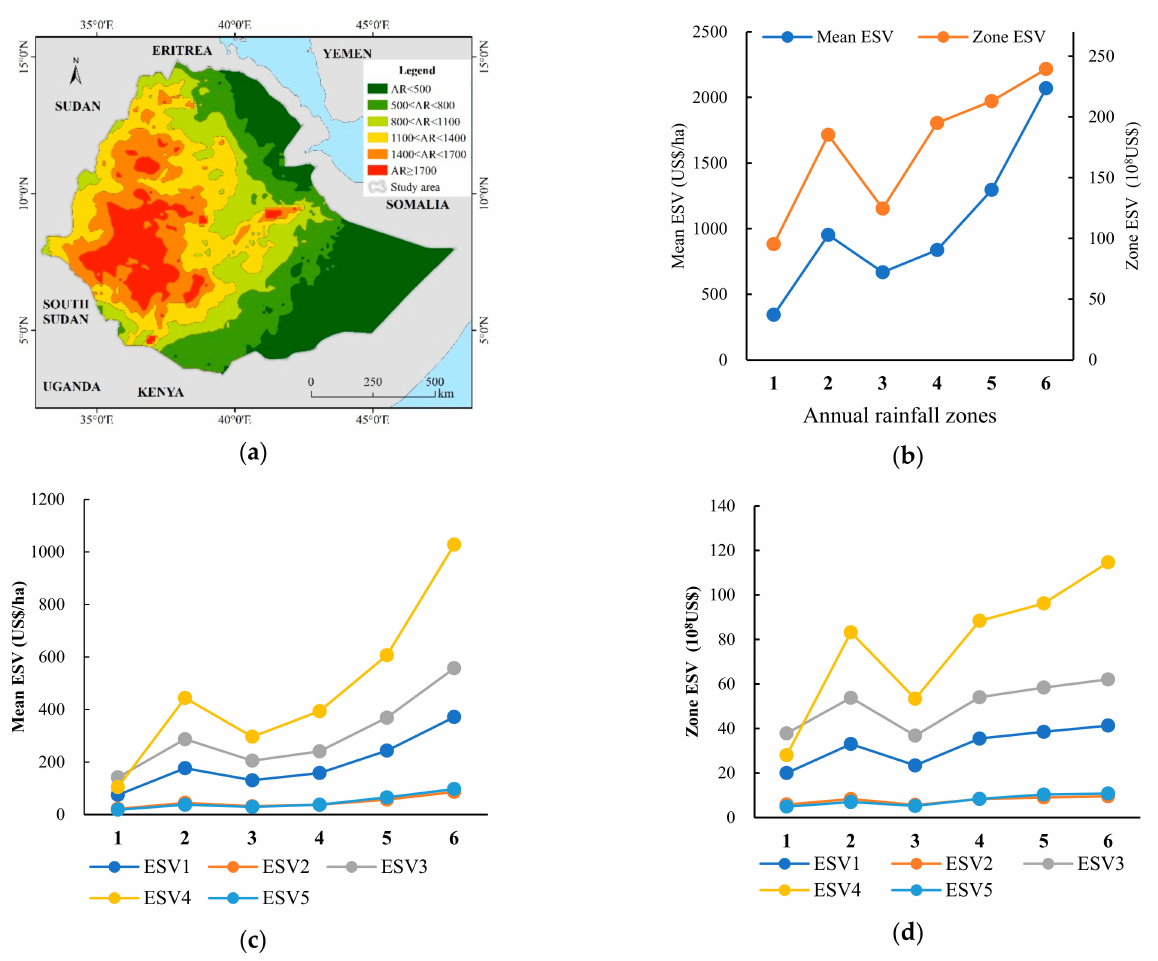
Figure 8. The annual rainfall zones and their ESV of grassland ecosystem. ( a ) the divided zones according to the annual rainfall. AR: annual rainfall. ( b ) the variation of ESV in different AR zones. ( c ) the variation of five mean ESVs in different AR zones. ( d ) the variation of five zone ESVs in different AR